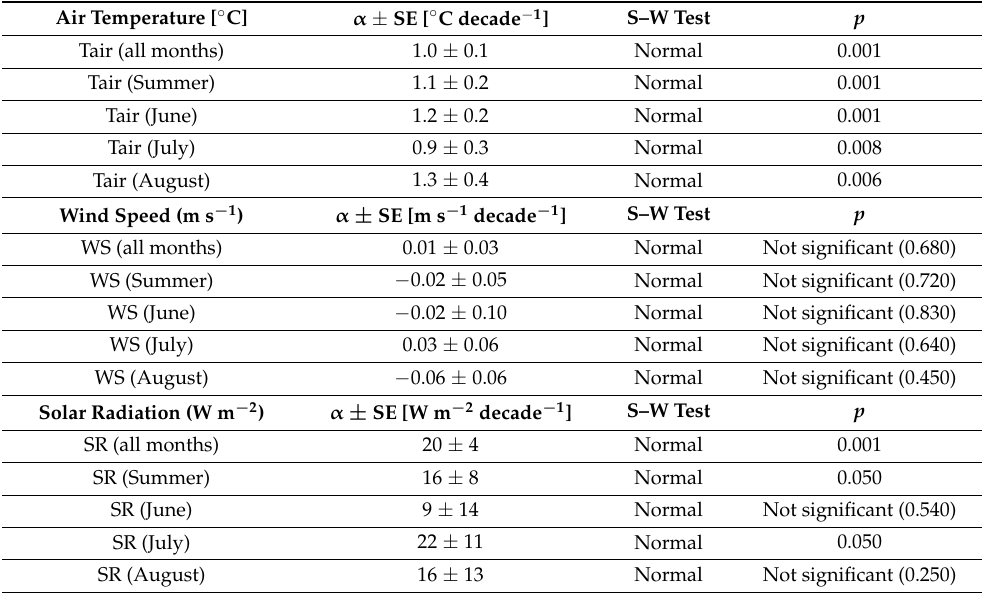
Table A2. The slope ( α ) with its standard error (SE) of the obtained linear fit of deseasonalized monthly anomalies of air temperature (Tair), wind speed (WS), and solar radiation (SR) measured at the Zemah meteorological station (9 LT–10 LT), during the study period. The decision based on the Shapiro-Wilk normality test for residuals (S-W test) and the significance level ( p ) is also displayed. In addition, slopes were obtained for year-to-year variations of Tair/WS/RS in the summer season and in each summer month